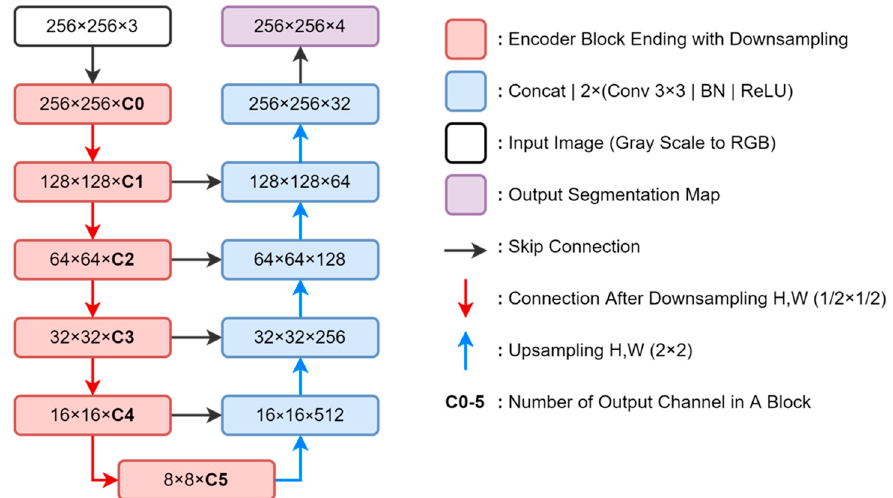
Figure 2. Encoder–decoder UNet suitable for any encoder.